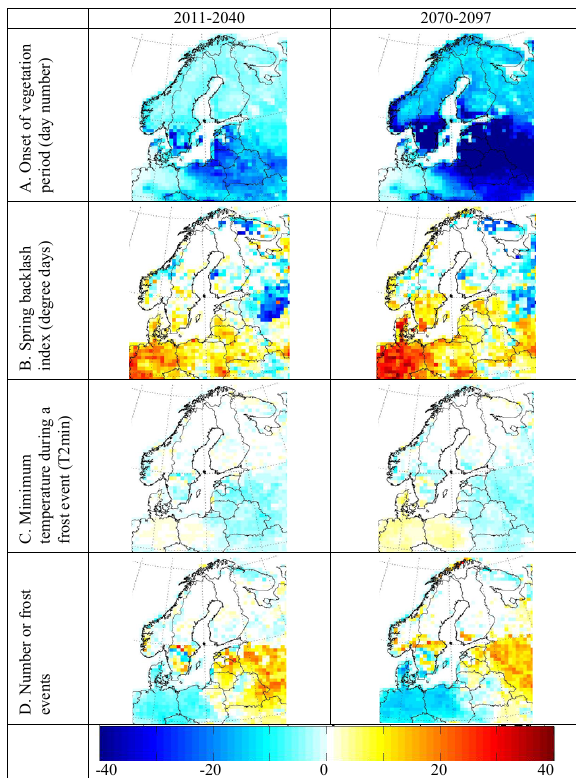
Figure 8. The start of vegetation period, together with the severity of spring backlashes, the number of Fig. 8. The start of the vegetation period, together with the sever- frost events and the minimum freezing temperature, calculated using temperature data from RCA3 driven at the boundary conditions with output from an ensemble of seven GCM data sets as input to the ity of spring backlashes, the number of frost events and the mini- spring backlash index. The change in the most severe events ( i.e. 10% of the most harmful events), mum freezing temperature, calculated using temperature data from calculated for the time slices of 2011-2040 and 2070-2097 in comparison with 1961-1990. RCA3 driven at the boundary conditions with output from an en- semble of seven GCM data sets as input to the spring backlash in- dex. The change in the most severe events (i.e. 10% of the most harmful events), calculated for the time periods of 2011–2040 and 2070–2097 in comparison with 1961–1990.